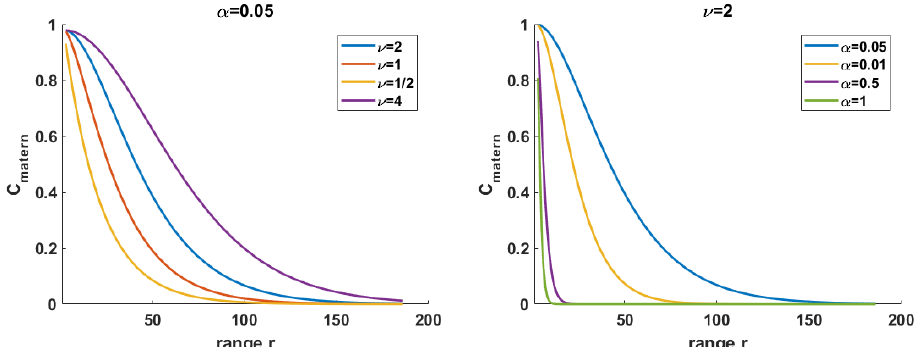
Figure A1. Matérn correlation function. Left: variation of the smoothness parameter  with Figure A1. Mat é rn correlation function. Left: variation of the smoothness parameter ν with α = 0.05. 0.05 = . Right: variation of the range parameter  by keeping  fixed to 2. Right: variation of the range parameter α by keeping ν fixed to